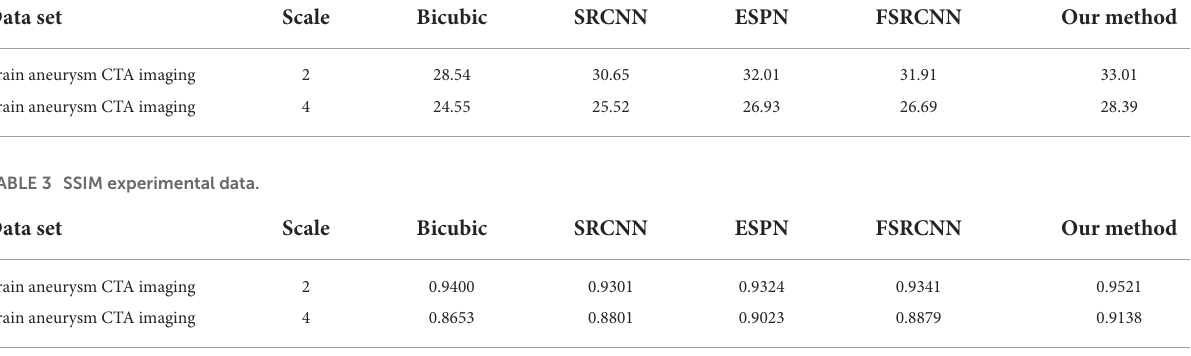
TABLE 4 Model checking